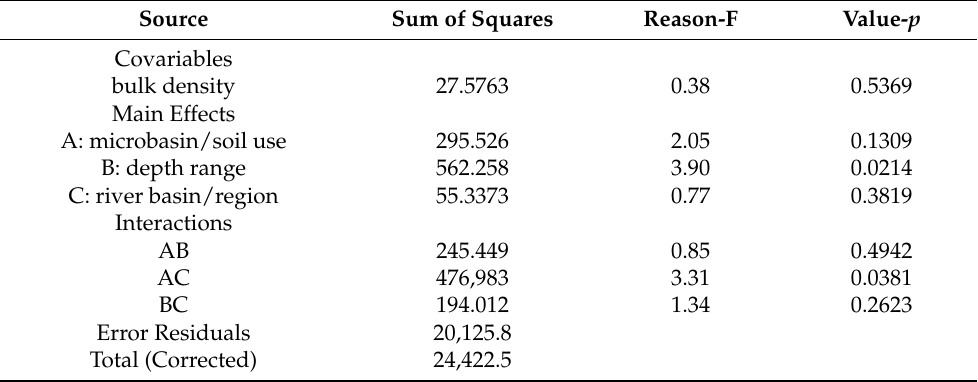
Table 7. Analysis of variance for mean (VSM) sum of squares type III.